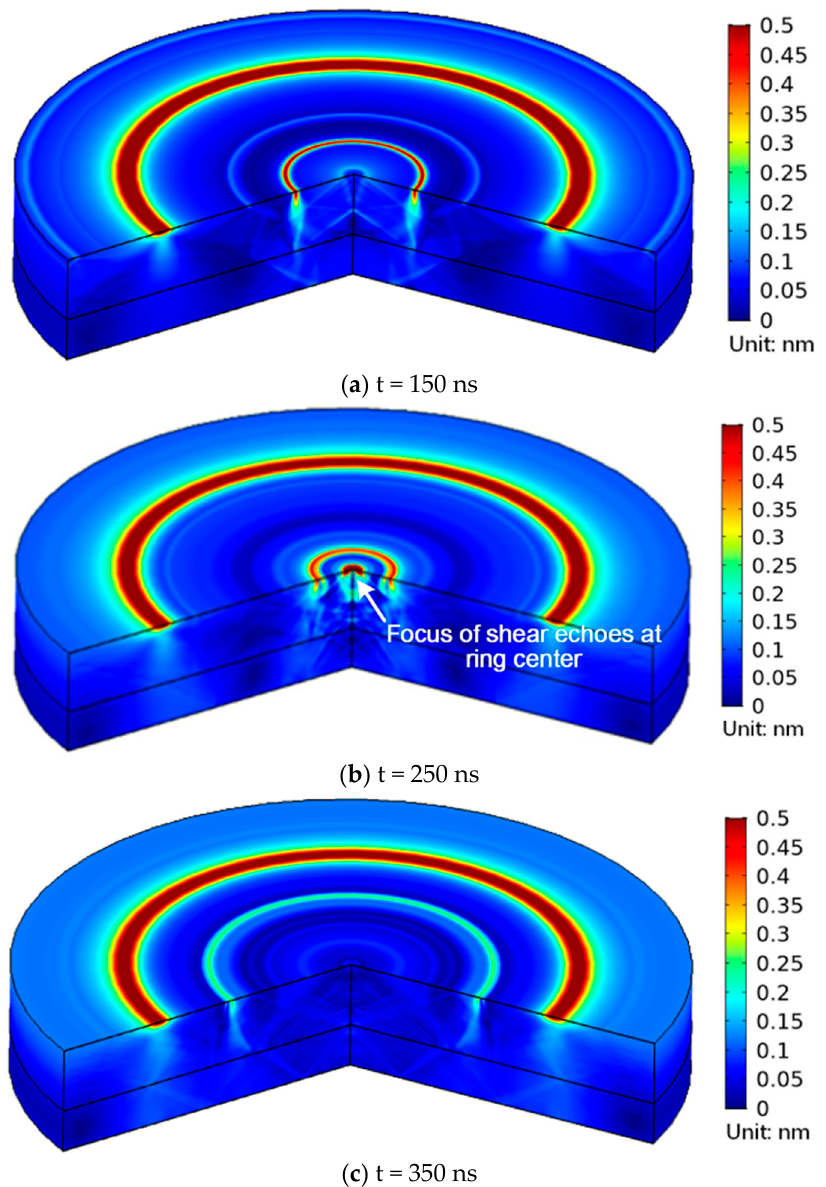
Figure 8. Volumetric ultrasonic displacement field at different times for R = 410 μ m.